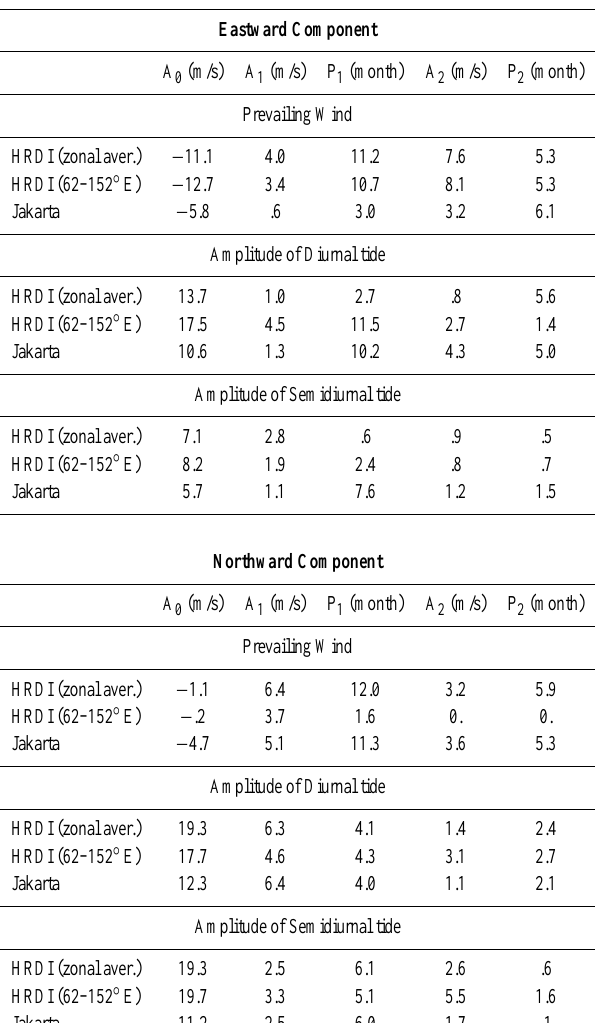
Table 3. Annual mean annual (A1, P1) and semiannual (A2, P2) harmonics (amplitude, phase) corresponding to the prevailing (di- urnal mean), diurnal and semidiurnal components of the eastward wind (top) and northward wind (bottom) component for 5 ◦ –10 ◦ S.